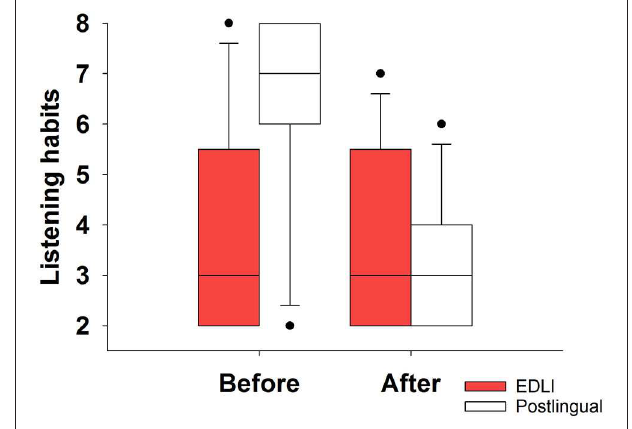
FIGURE 3 | The music listening habits before and after implantation for EDLI and postlingually deafened CI users. The box descriptions are similar to those of Figure 2